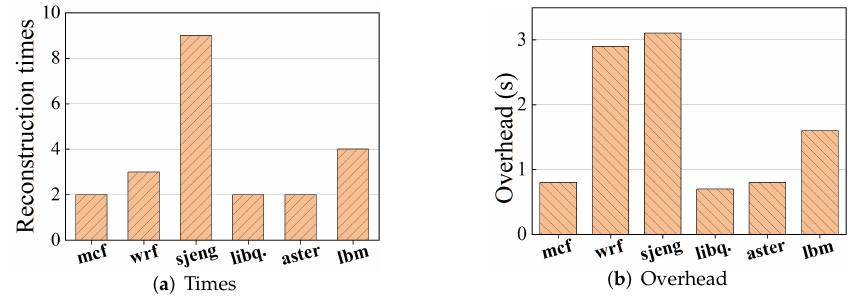
Figure 11. Overhead of architecture dynamic